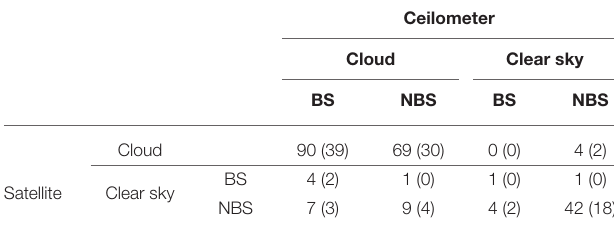
TABLE 6 | Overview of the comparison between ceilometer and satellite detections at the Neumayer station, number of observations (% relative to the total number,